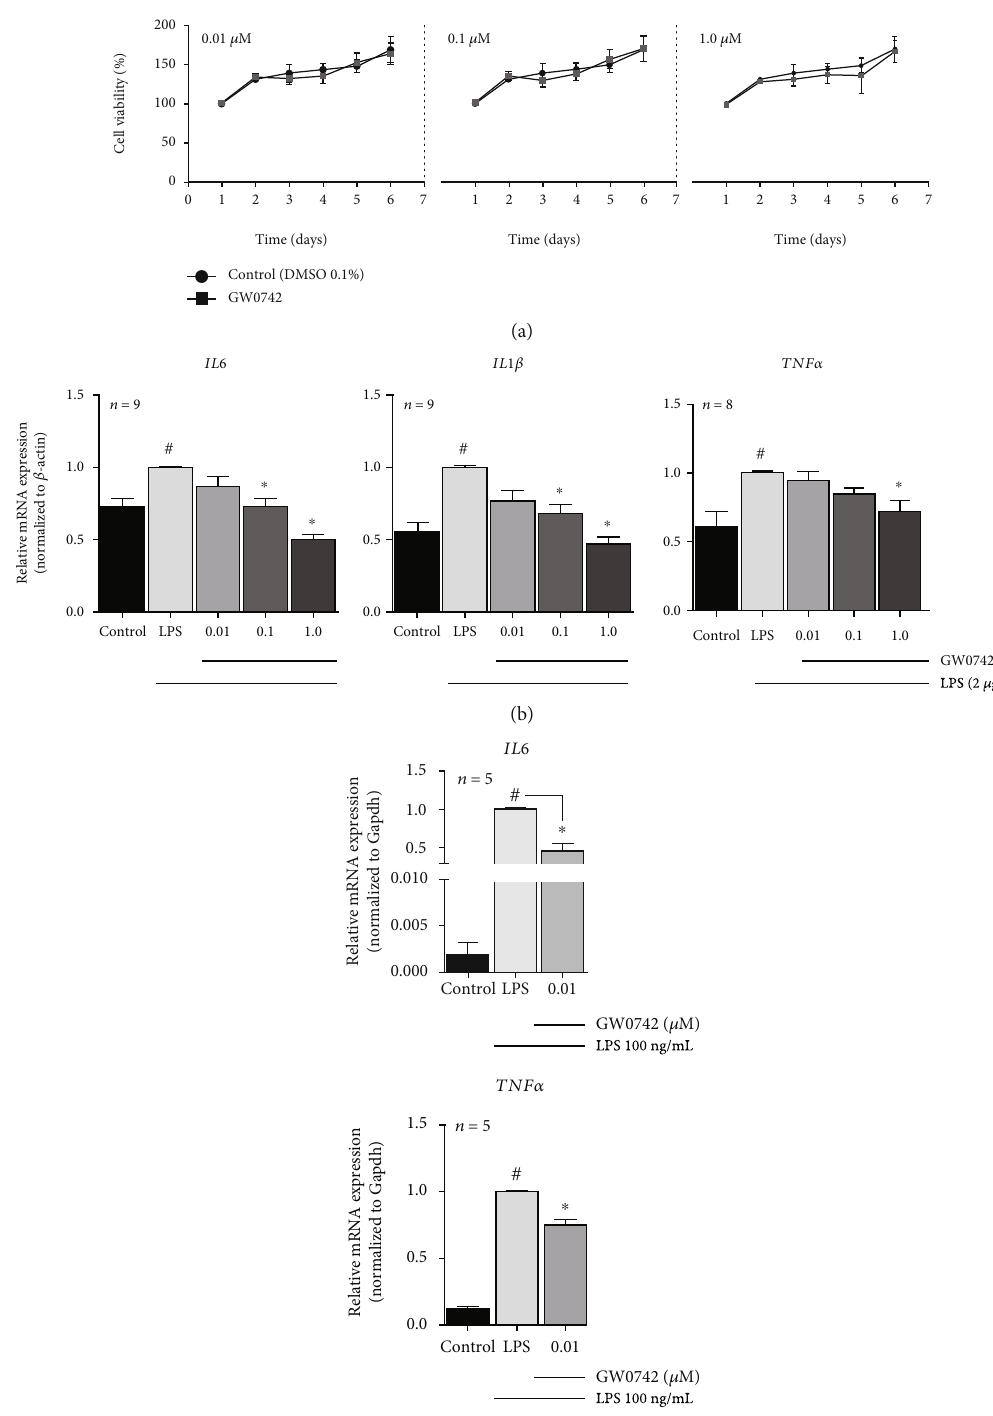
Figure 2: GW0742-activated PPAR β / δ represses cytokine gene expression in LPS-stimulated hDPCs: (a) treatment with GW0742 (0.01, 0.1, and 1.0 μ M) did not alter hDPC viability. (b) Real-time qPCR analyses of IL6 , IL1 β , and TNF α in cultured hDPCs pretreated with GW0742 (for 24h) and added LPS (2 μ g/mL) for 4 h before harvesting. GW0742 signi fi cantly reduced LPS-induced IL6 and IL1 β at 0.1 μ M and LPS- induced IL6 , IL1 β , and TNF α at 1.0 μ M. (c) Pretreatment with 0.01 μ M GW0742 (for 24h) signi fi cantly reduced Il6 and Tnf α mRNA levels in LPS-stimulated RAW264.7 cells (for 24 h) ( p < 0 : 05 ; # vs. control; ∗ vs. LPS by Kruskal – Wallis and post hoc Dunn ’ s test; mean ± S : E : M : n = per group ). Control = DMSO 0 : 1 %